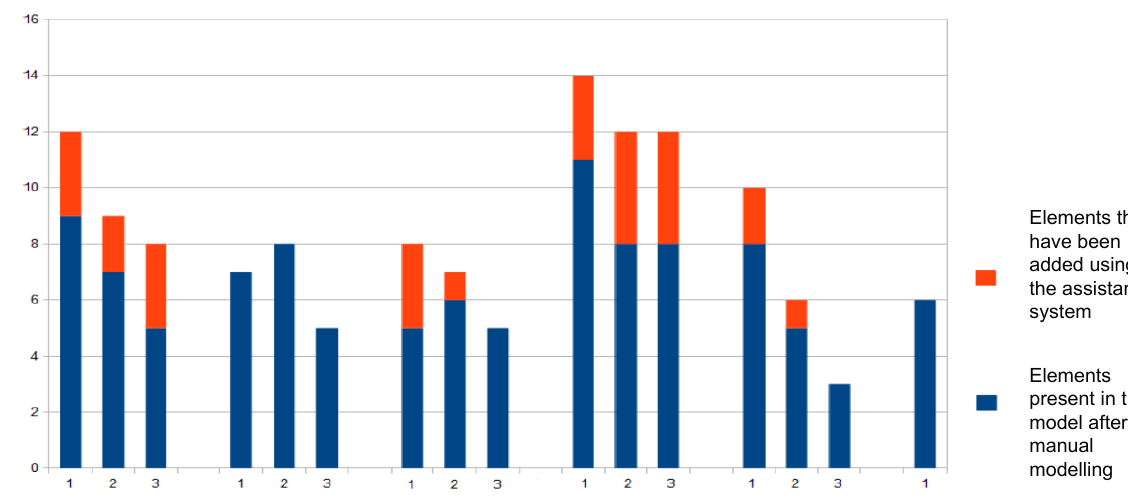
Figure 10. Additionally inserted model elements by assisted modeling